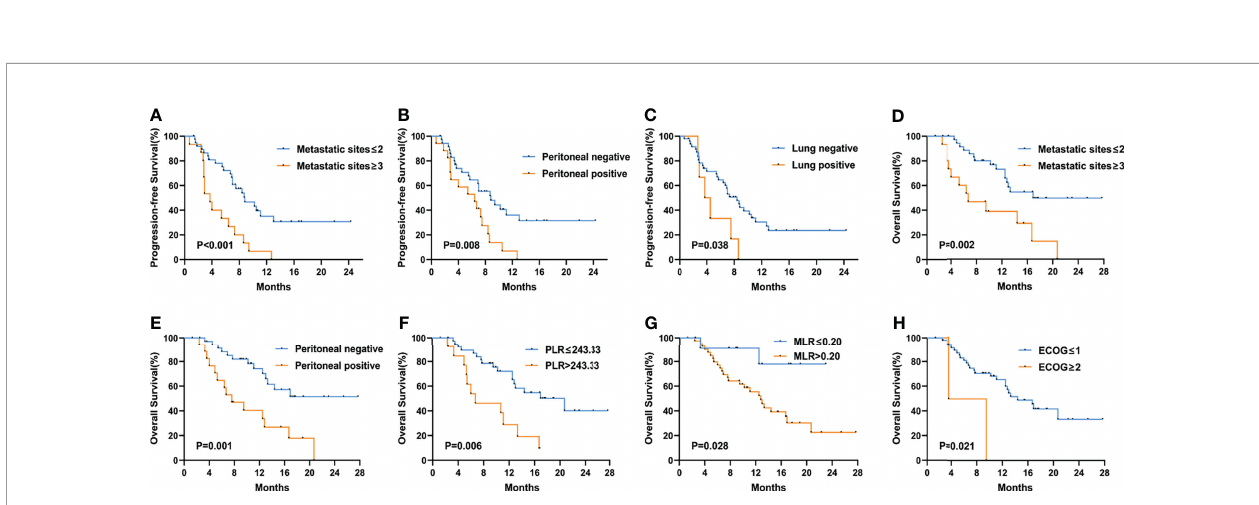
FIGURE 3 | Kaplan – Meier curves of progression-free survival (PFS) and overall survival (OS) in the fi rst-line treatment according to PFS: metastatic sites (A) , peritoneal metastasis (B) , lung metastasis (C) ; OS: metastatic sites (D) , peritoneal metastasis (E) , PLR (F) , MLR (G) , and ECOG PS (H) at baseline. The P values were calculated using the log-rank test